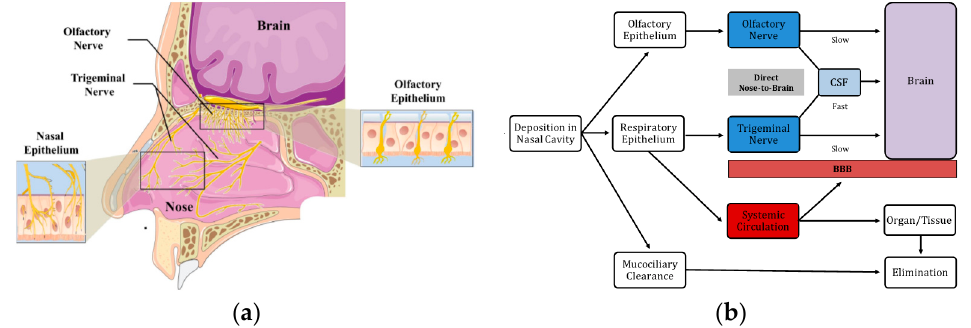
Figure 1. ( a ) Nasal innervation; ( b ) Nose-to-brain (N2B) pathways of drug delivery (modified from [15] and [16] with permission).